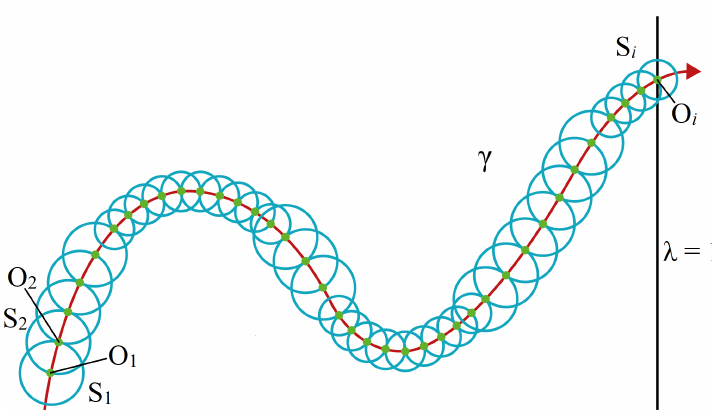
Figure 3. Hyperspherical algorithm with variable